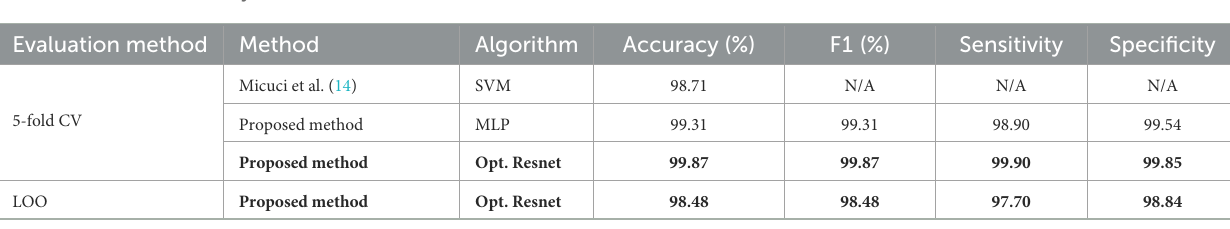
TABLE 3 Benchmark for binary classification of ADLs and